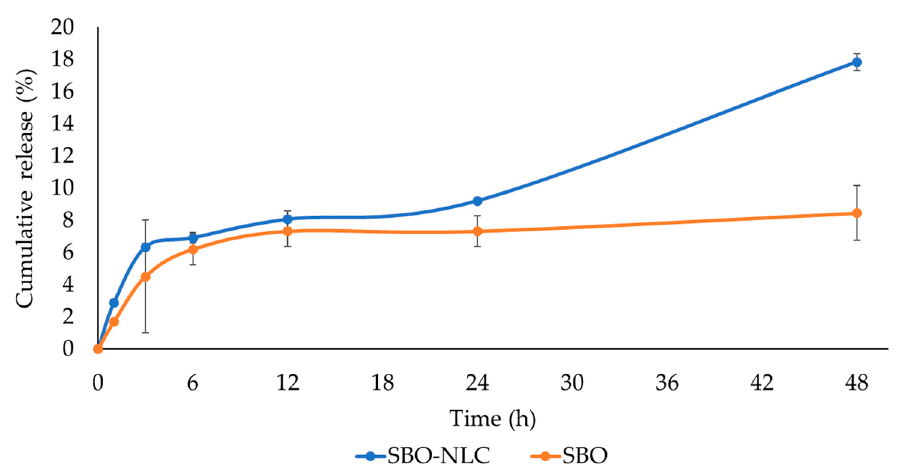
Figure 8. Graphical representation of the cumulative release profile of the SBO-NLCs. Significantly different from the free SBO.